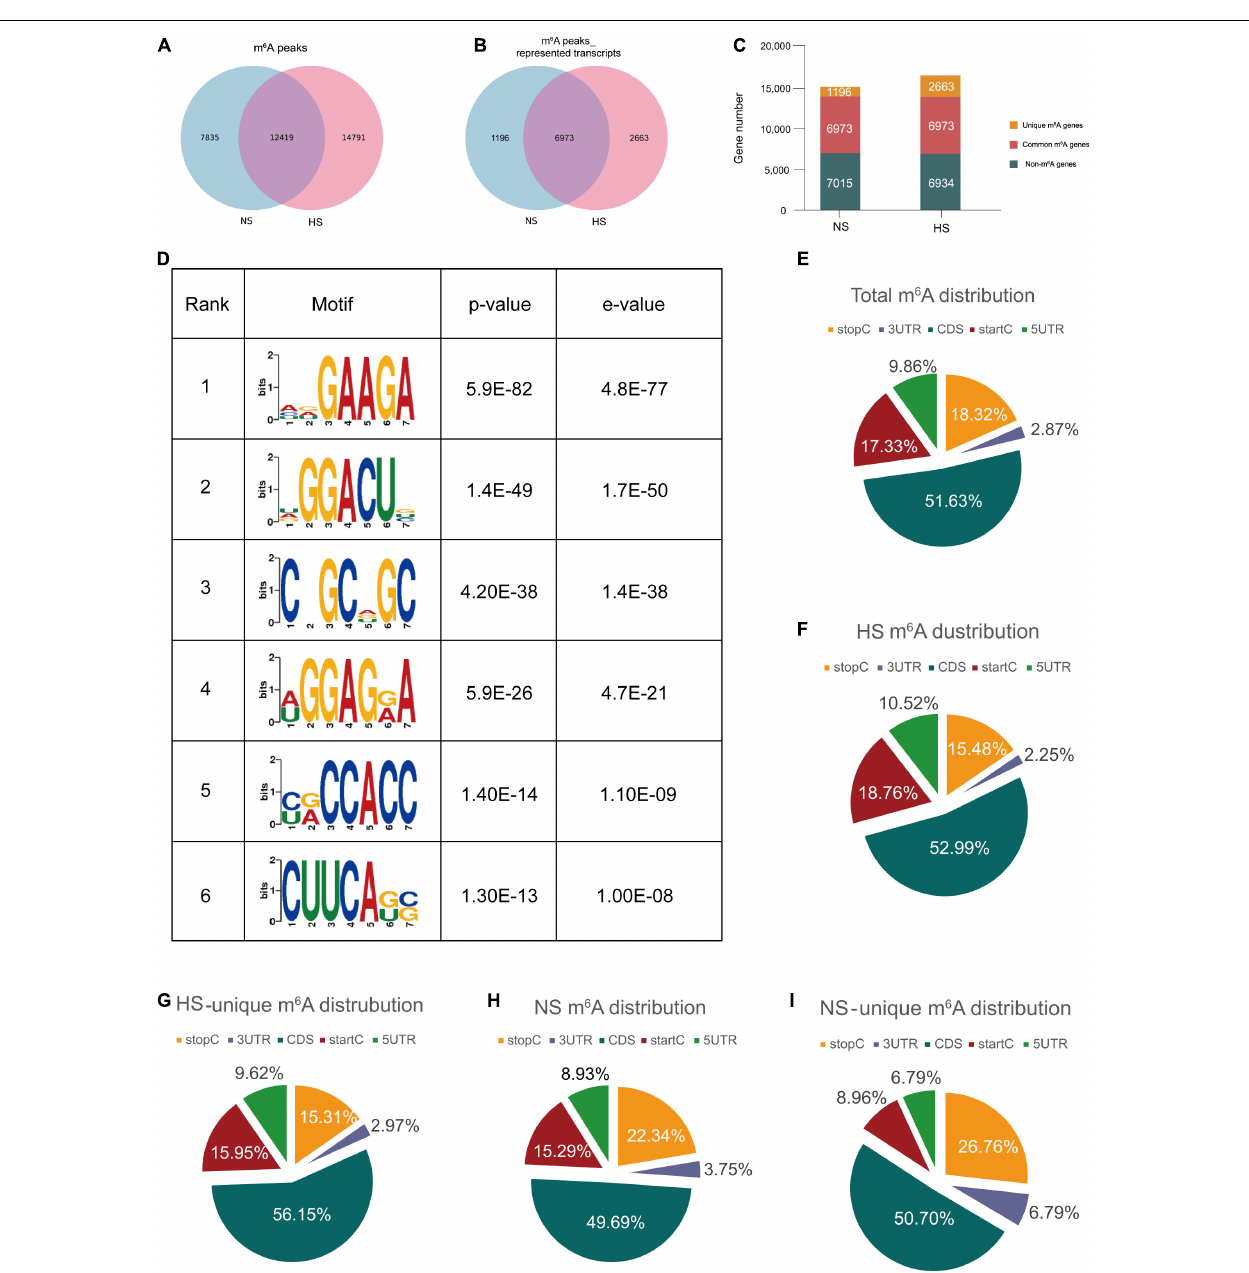
FIGURE 1 | Transcriptome-wide m 6 A-seq and analysis of m 6 A peaks. (A) Identification of m 6 A peaks by model-based analysis of the ChIP-seq algorithm. The numbers of hypertrophic scar-unique, normal skin-unique, and common m 6 A peaks are shown; (B) Venn diagram of m 6 A peak–represented transcripts of the two groups; (C) summary of m 6 A-modified genes identified in the m 6 A-seq. (D) The top six motifs enriched across the m 6 A peaks identified from HS. (E–I) The proportion of m 6 A peak distributions: the proportion of m 6 A peak distribution in the indicated regions in NS and HS samples (E) ; the proportion of m 6 A peak distribution in the indicated regions in NS (F) ; the proportion of m 6 A peak distribution in the indicated regions in HS (G) ; the loss of existing m 6 A peaks (NS-unique peaks) (H) or appearance of new m 6 A peaks (HS-unique peaks) (I) in the HS group. HS, hypertrophic scar group; NS, normal skin